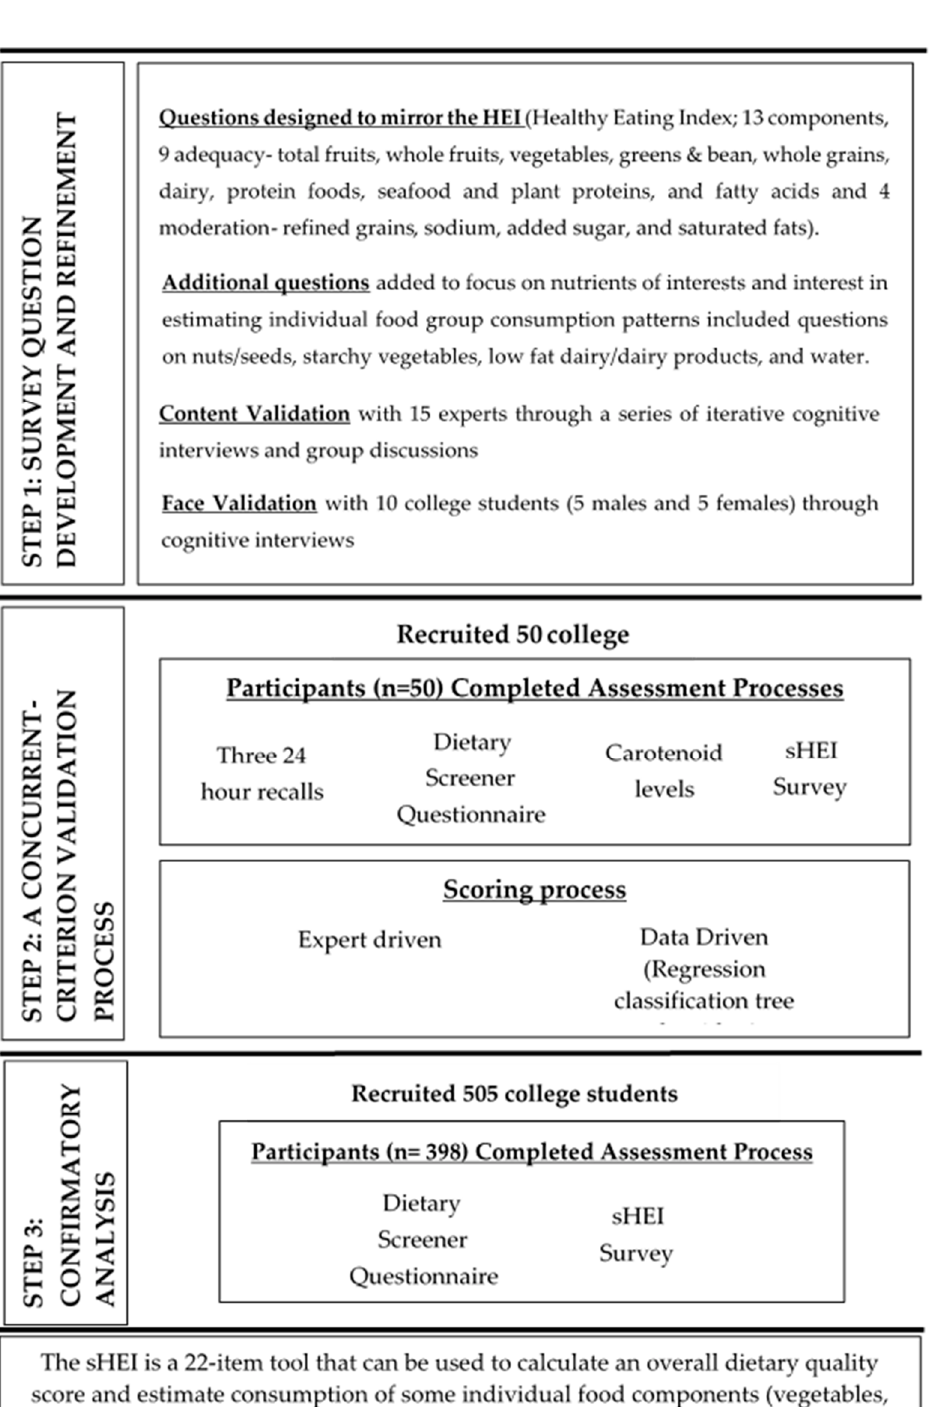
Figure 1. Process of developing and validating a survey tool (the sHEI) to estimate dietary quality and individual food group consumption of vegetables, fruits, whole grains, protein, seafood and plant proteins, refined grains, sodium, saturated fats, and water.